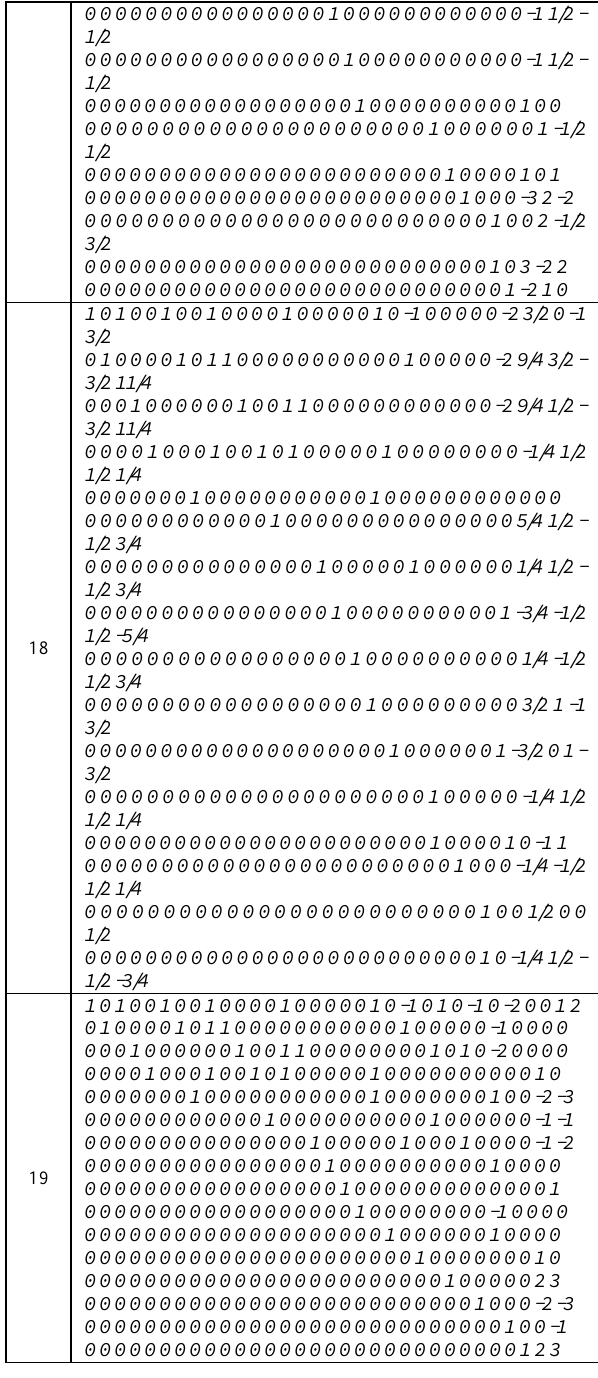
Table 4: Output of Md(h)*(after Gaussian Elimination) (above).